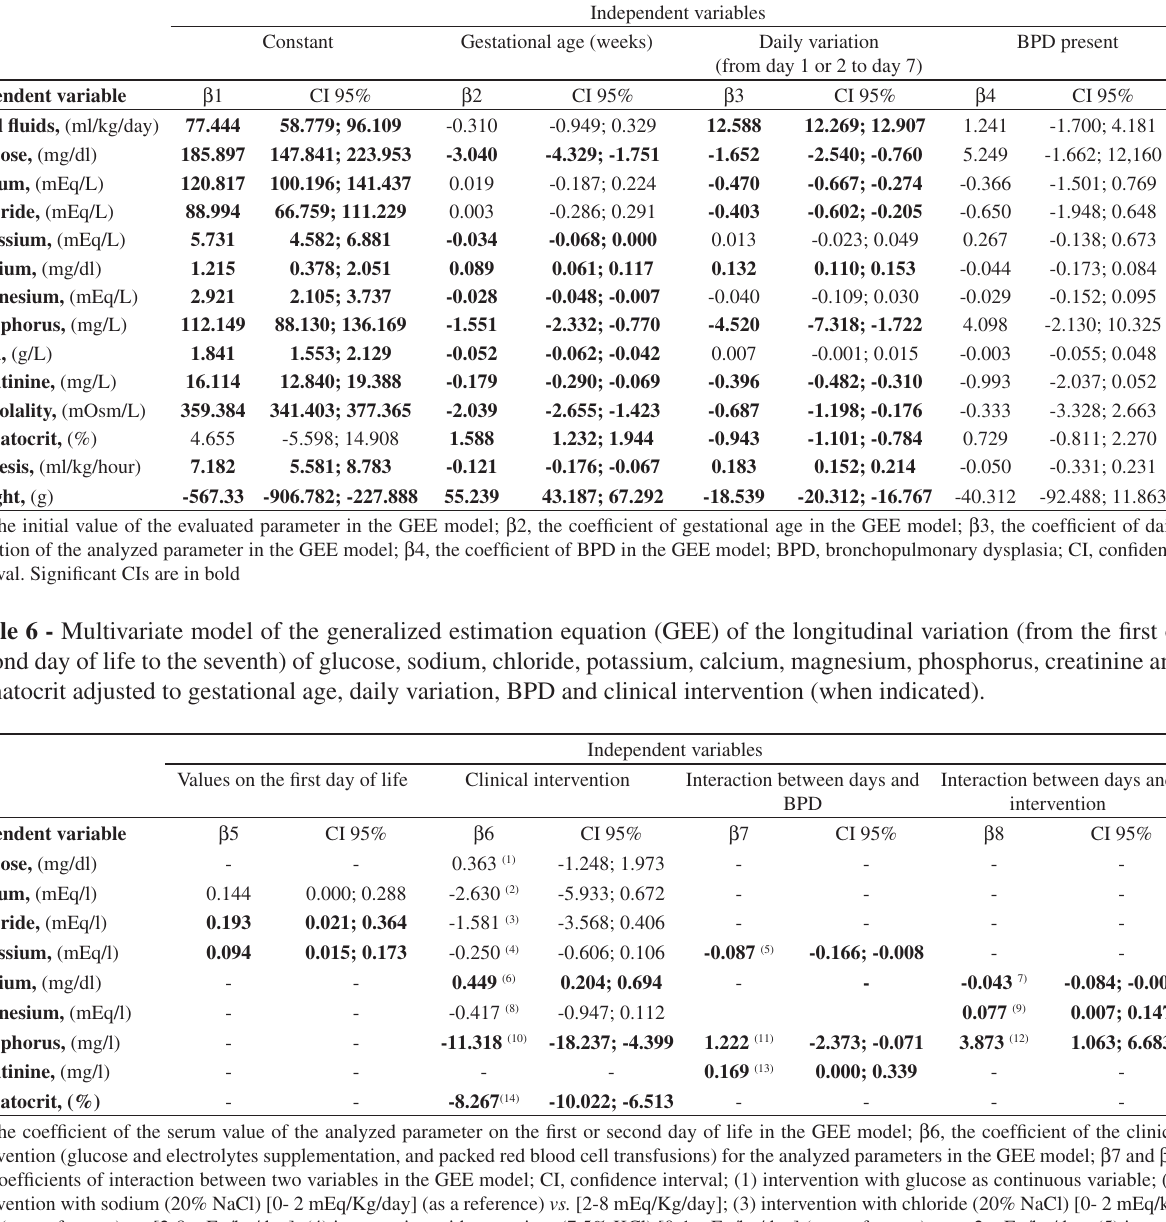
Table 6). The rate of transfusions in non-BPD patients